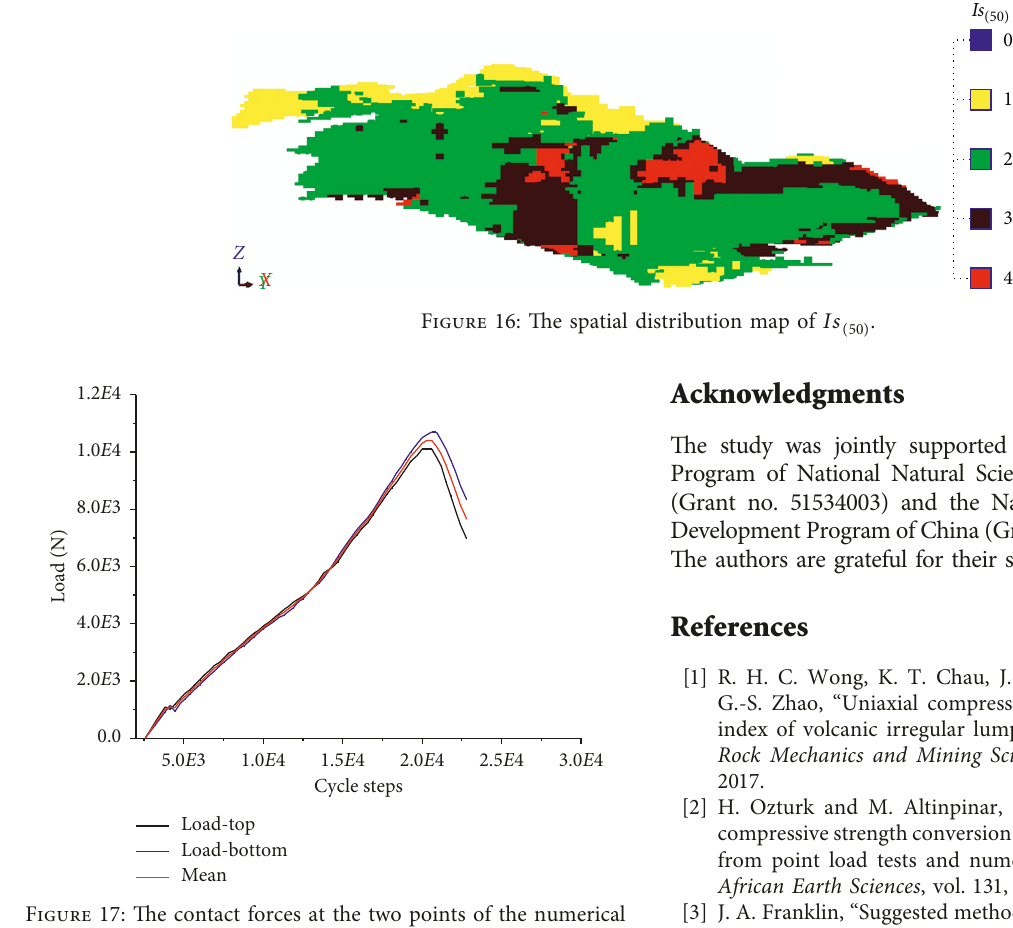
Figure 17: The contact forces at the two points of the numerical